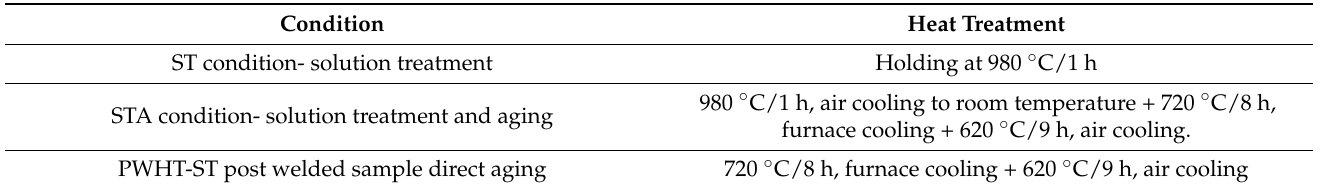
Table 2. Heat treatment details for Inconel 718.